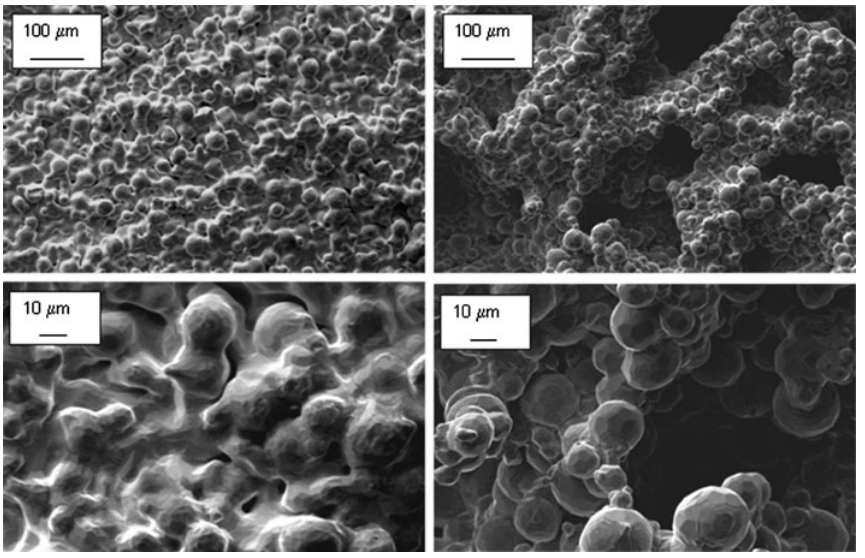
Figure 1. Scanning Electron Microscopy (SEM) images of high relative density ( 0.91  , left ) and low-density ( 0.45  , right )